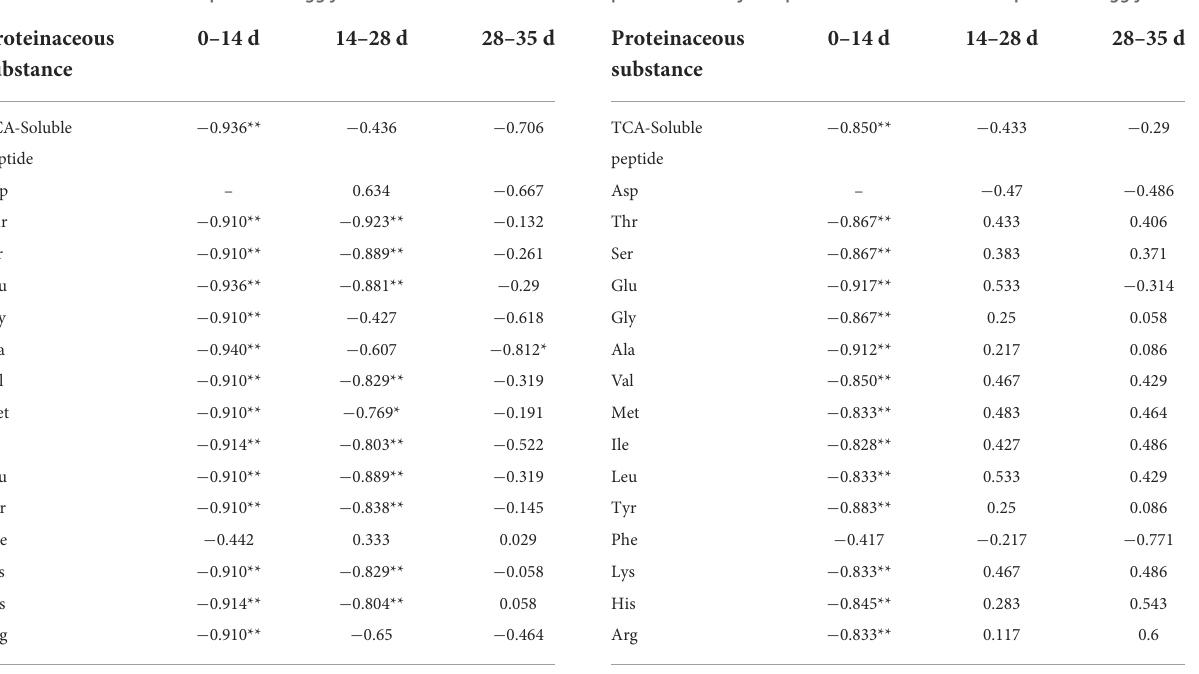
TABLE 3 Spearman correlation analysis between pH and proteinaceous substance in preserved egg yolk.